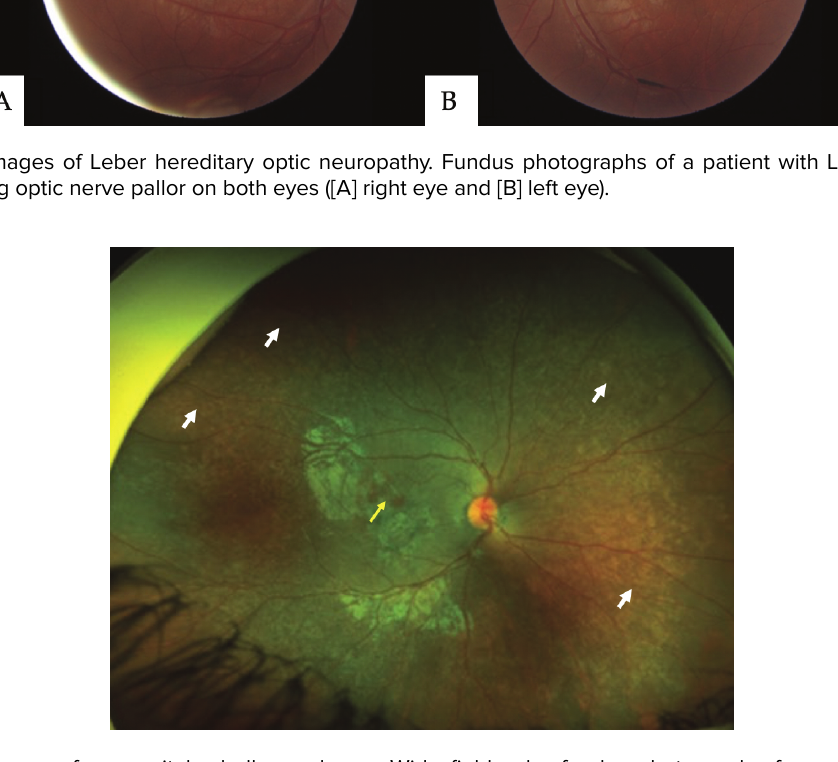
Figure 4. Fundus image of congenital rubella syndrome. Wide field color fundus photograph of a seven-year-old girl with congenital rubella syndrome showing diffuse changes of salt and pepper pigmentary retinopathy throughout the fundus (white arrows). The patient also had subretinal hemorrhage with type 2 choroidal neovascular membrane (yellow arrow).